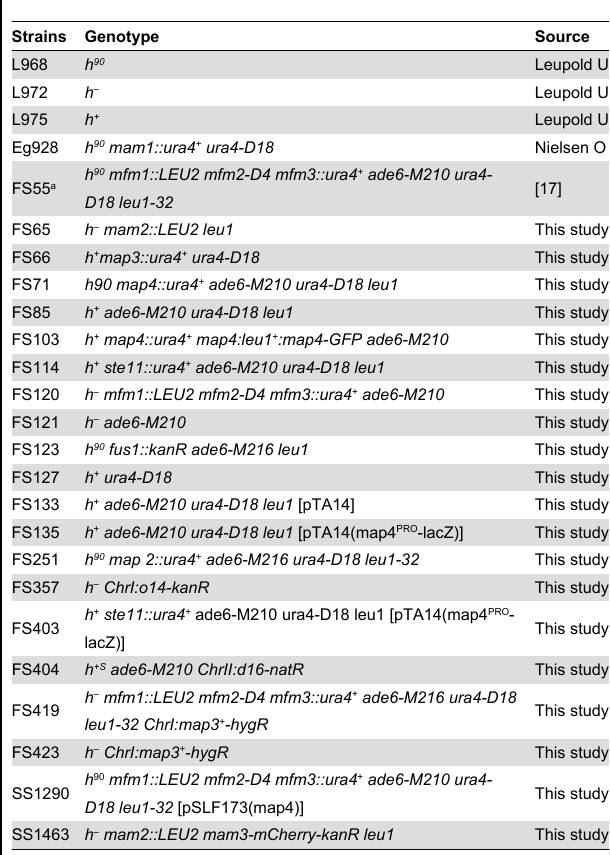
Table 1. Strains used in this